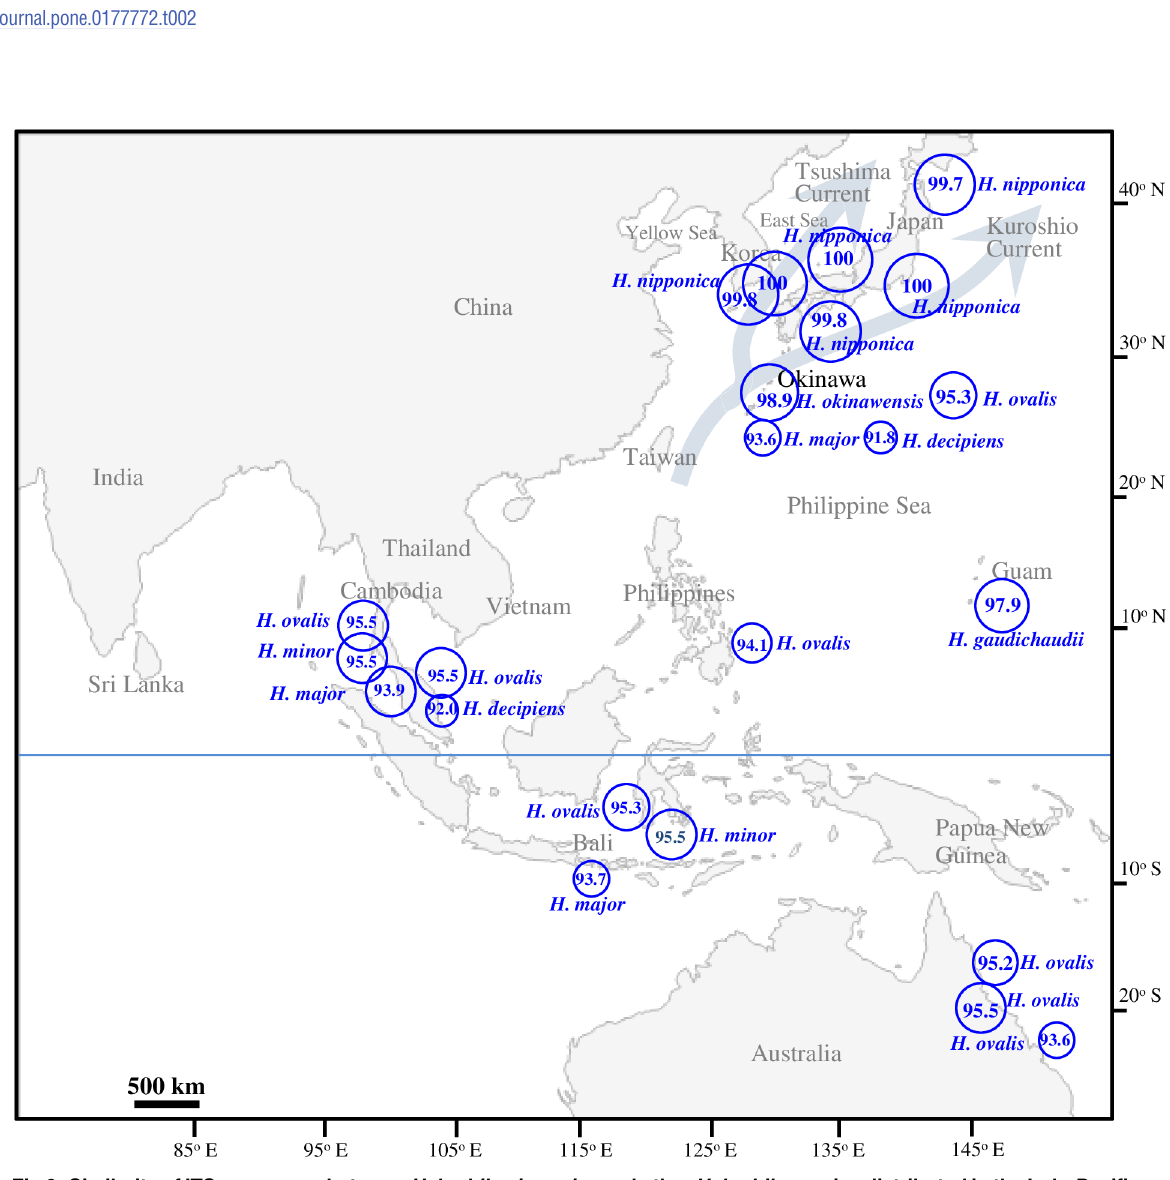
Fig 3. Similarity of ITS sequences between Halophila nipponica and other Halophila species distributed in the Indo-Pacific and western Pacific regions.